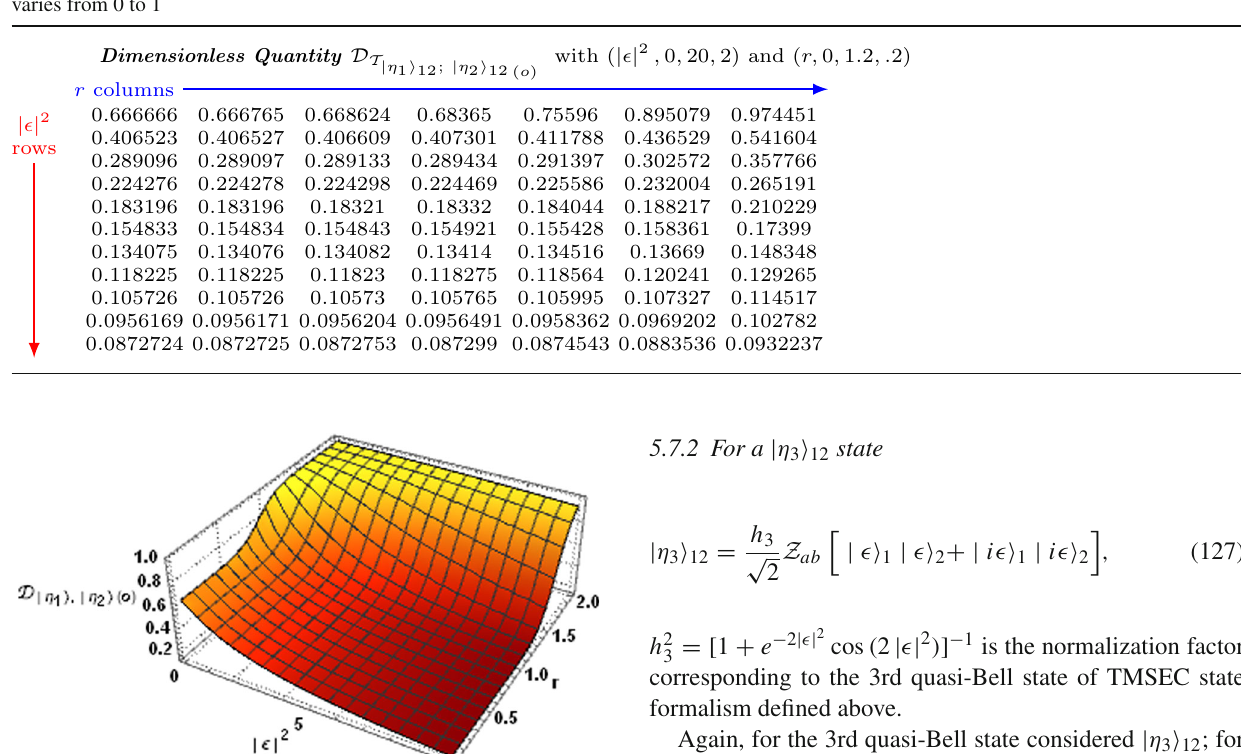
Table 9 Numerical values of D T for some range and choices of coherent and squeezing parameters. Here, | (cid:11) | 2 takes on value from 0 to 20 and r varies from 0 to 1